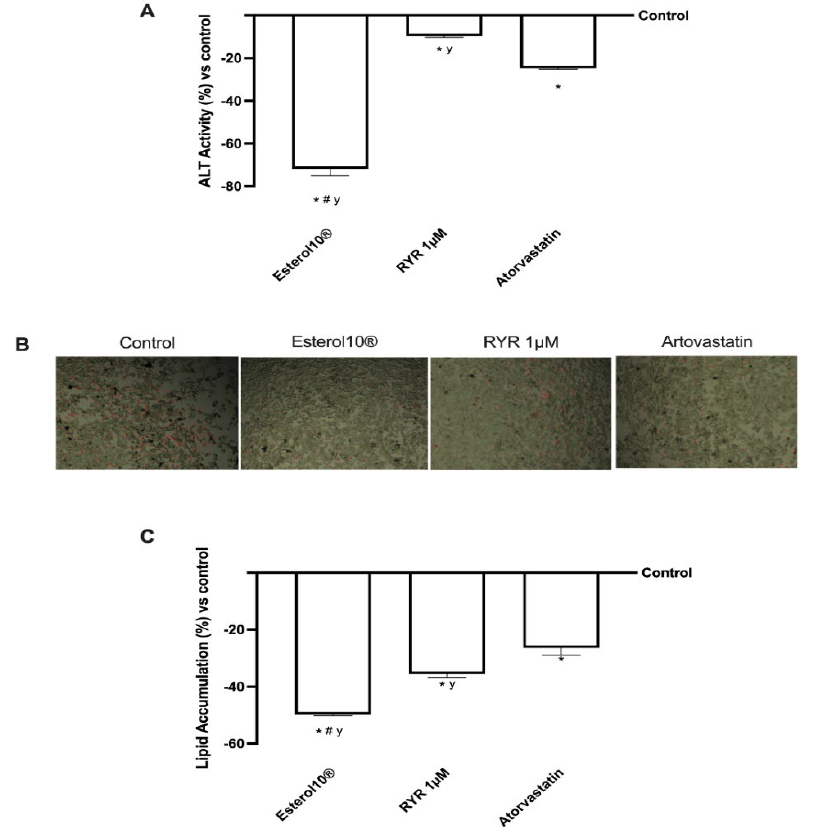
Figure 6. Tissue integrity analysis. In ( A ), ALT activity was measured by an ELISA test. Images captured under the microscope at an original magnification of × 20 and reported in ( B ) showed the intercellular oil droplets stained by the Oil Red stain. These oil droplets are solubilized for quantification by spectrophotometric analysis reported in ( C ). The abbreviations are the same as shown in Figure 1. Data are mean ± SD of five independent experiments performed in triplicate. * p < 0.05 compared to the control; # p <0.05 vs. RYR; y p <0.05 vs.